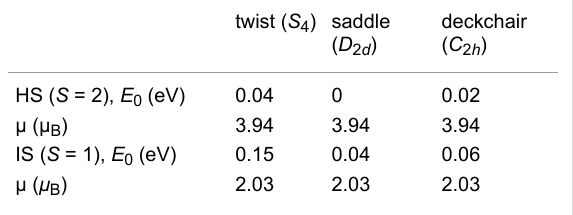
Table 1: Relative energy, E 0 , and magnetic moment, μ , of S 4 , D 2 d and C 2 h conformations in the states S = 1 and S = 2. The reference energy is that of the HS D 2 d